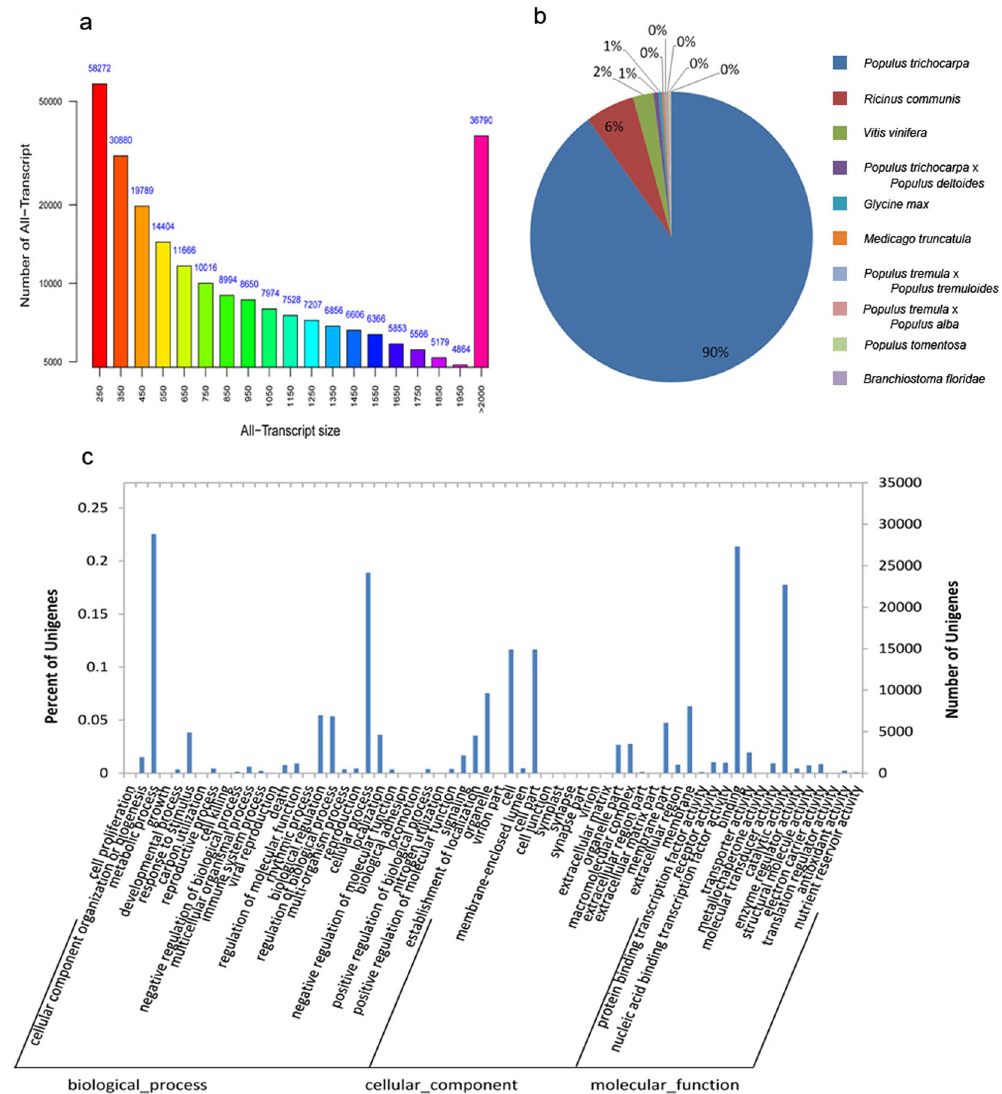
Figure 2. Characteristics of samples UniGenes. ( a ) Length distribution of all-unigene, ( b ) percentage of unigenes matching the top 10 species using BLASTx in the NR database, ( c ) classification of GO annotations at the secondary